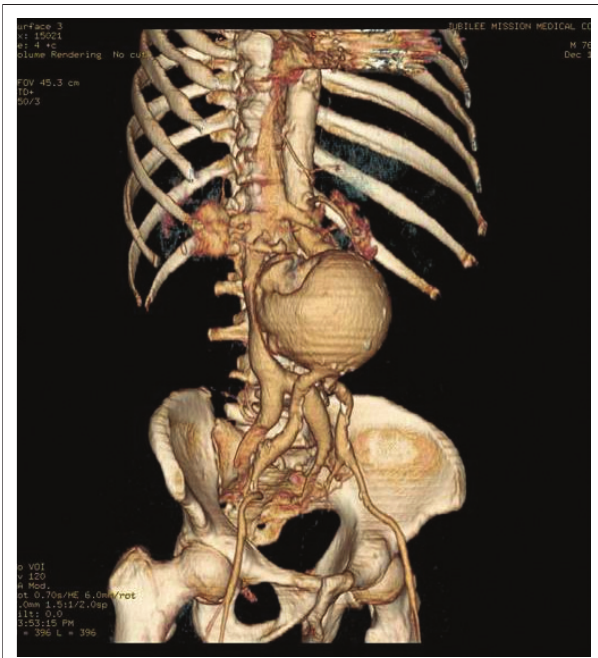
FIGURE 4: Volume-rendered arterial phase image displays the opacified aneurysm, iliac veins and inferior vena